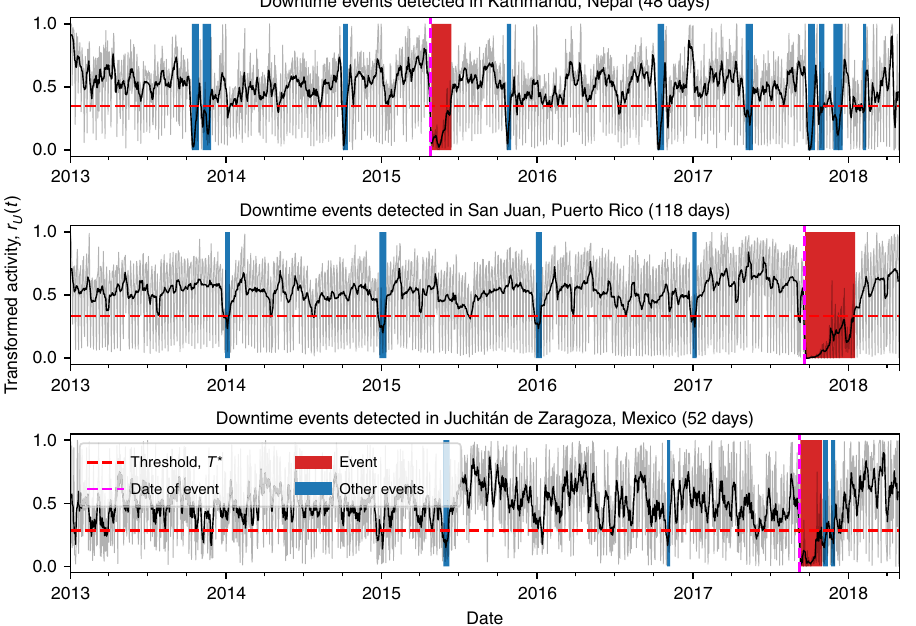
Fig. 4 Detected downtime events. Downtime events longer than seven days detected in a Kathmandu, Nepal, b San Juan, Puerto Rico, c Juchitán de Zaragoza, Mexico. Transformed posting activity data, r U ð t Þ (Eq. (4)), is shown in grey, its one week rolling mean is shown in black and the thresholds T (cid:4) estimated with the elbow method are marked with dashed horizontal red lines. The detected periods of downtime are highlighted with vertical red bars (the natural hazard related event) and blue bars (other events). The date of the event in each region is marked by a dashed vertical magenta